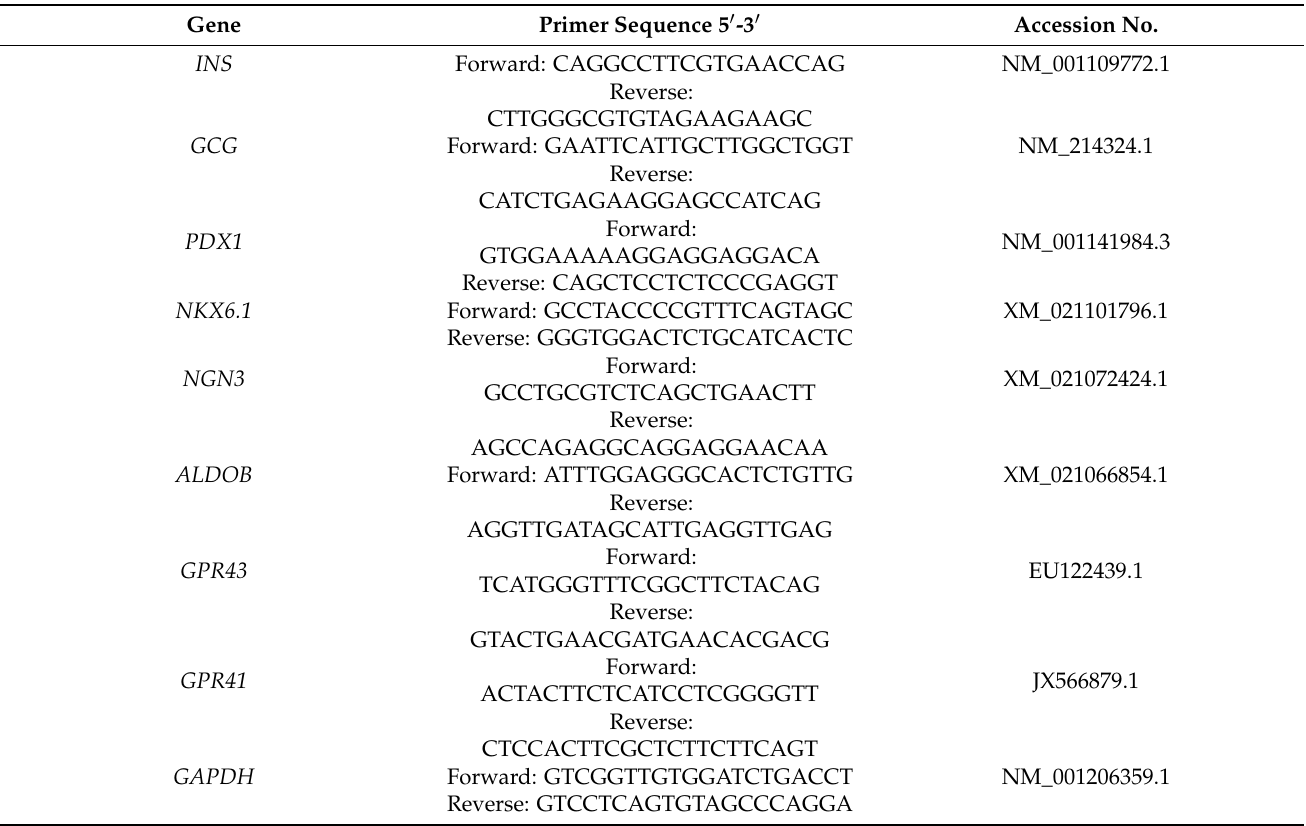
Table 1. Primer sequences for quantitative real